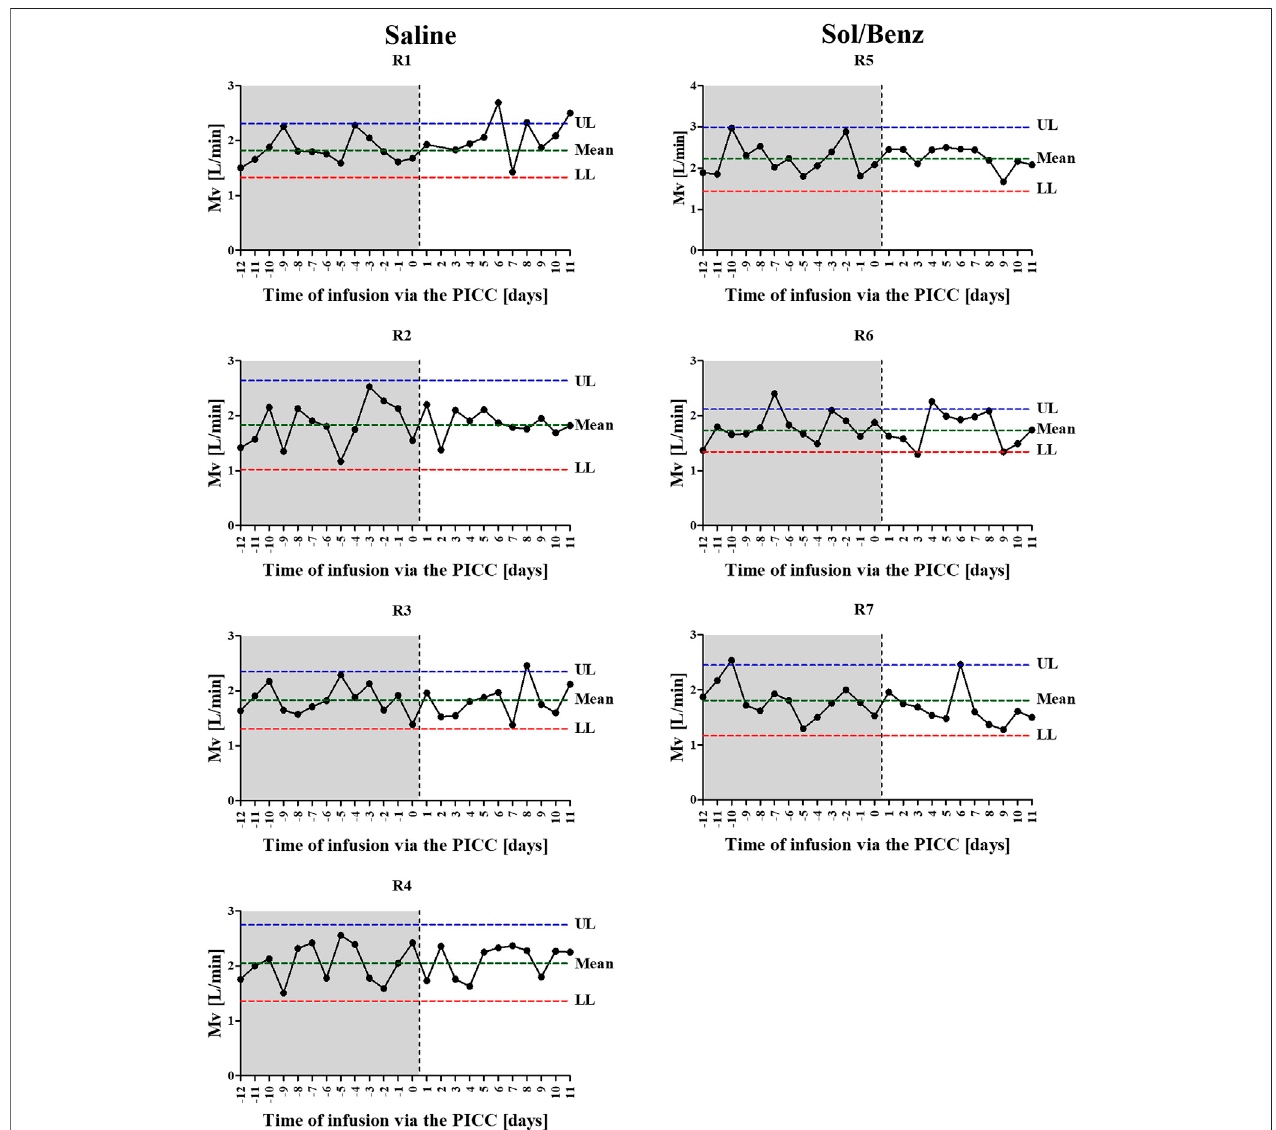
FIGURE 3 | Individual Mv values before and during the IV continuous infusion. Following acclimation to carrying the minipumps, 13 independent measurements were collected over 13 consecutive days and were used to calculate the individual normal mean and standard deviation of Mv values (preinfusion period: area in gray). Following PICCinsertion(the time pointisdesignatedbytheverticaldashedline) and duringthe11-daysIVcontinuous infusion, theMvvaluesweredeterminedonceper day (infusion period: area in white). Left panel: saline infused rabbits. Right panel: Sol/Benz infused rabbits. The con fi dence limits were determined as the mean ± 2 * SD.